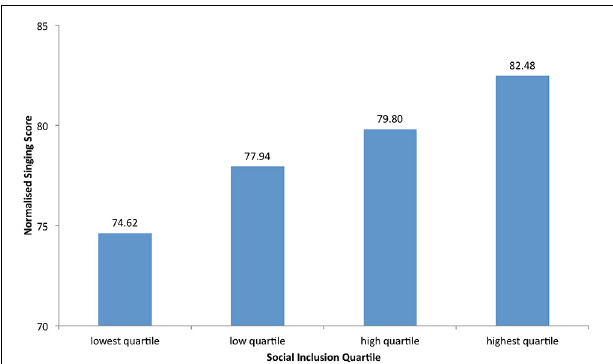
FIGURE 1 | A linear relationship is evidenced between participants’ mean social inclusion (sense of self and of being socially integrated) responses in quartiles matched against the same individuals’ normalized singing score (rated out of 100, where 100 equates to skilled in-tune singing and 50 is much less developmentally able, such as significant vocal pitch errors against the target melodies) for n = 6087 matched